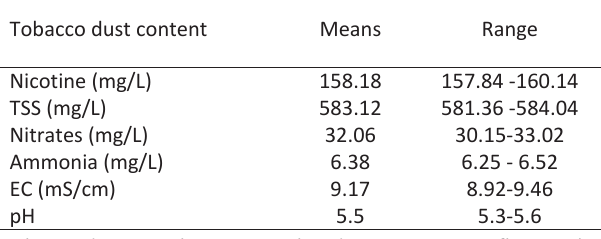
Tobacco dust samples were analyzed in a continuous flow analy-